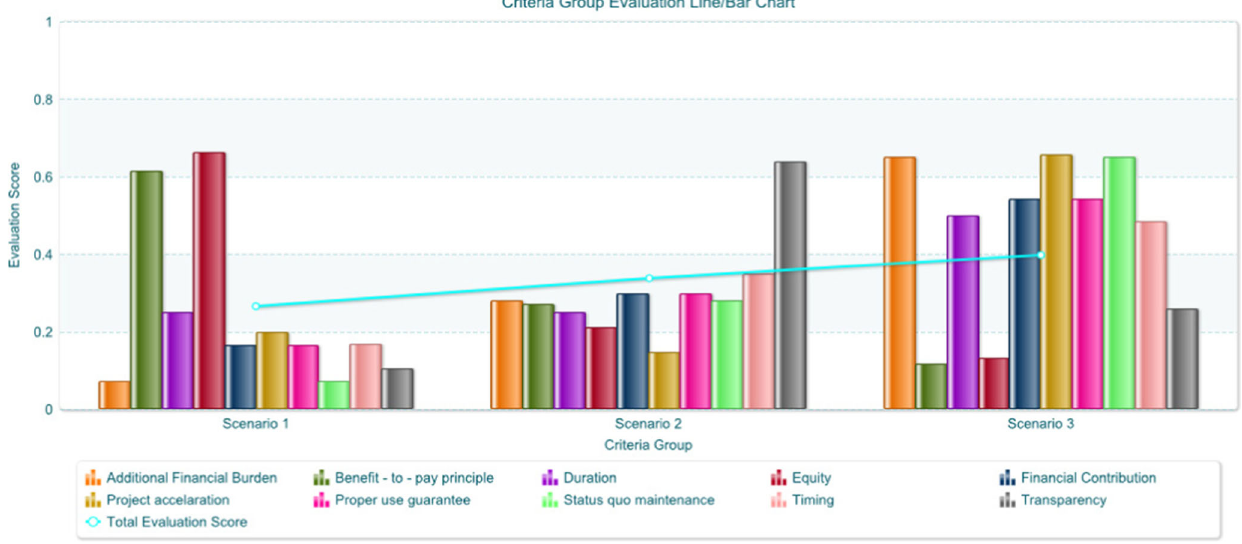
Fig. 10 Criteria Group E Evaluation Line/Bar Chart (MAMCA Software, own